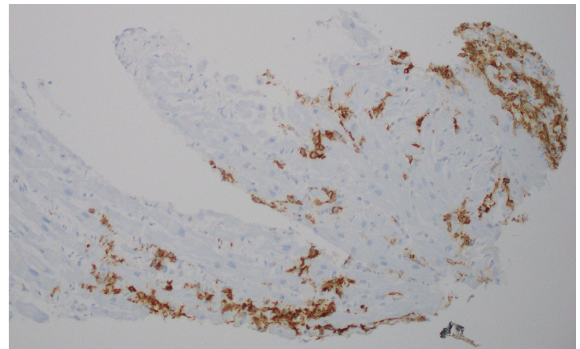
Figure 7: Immunohistochemical stain of cardiac muscle showing that the cells are positive for CD791, a B-cell